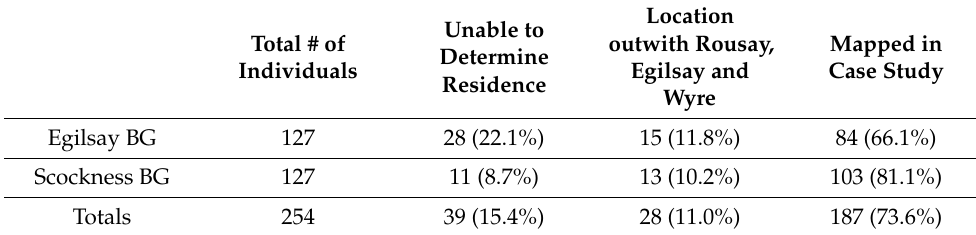
Mapped in Case Study